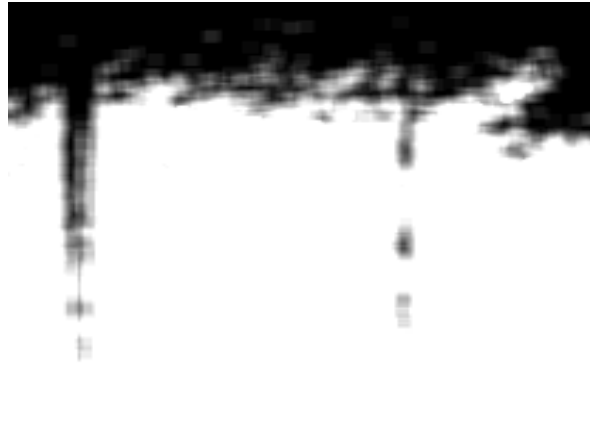
Figure 6. The image after pooling. Table 3. Model Hyper parameter settings in the second part of the study.